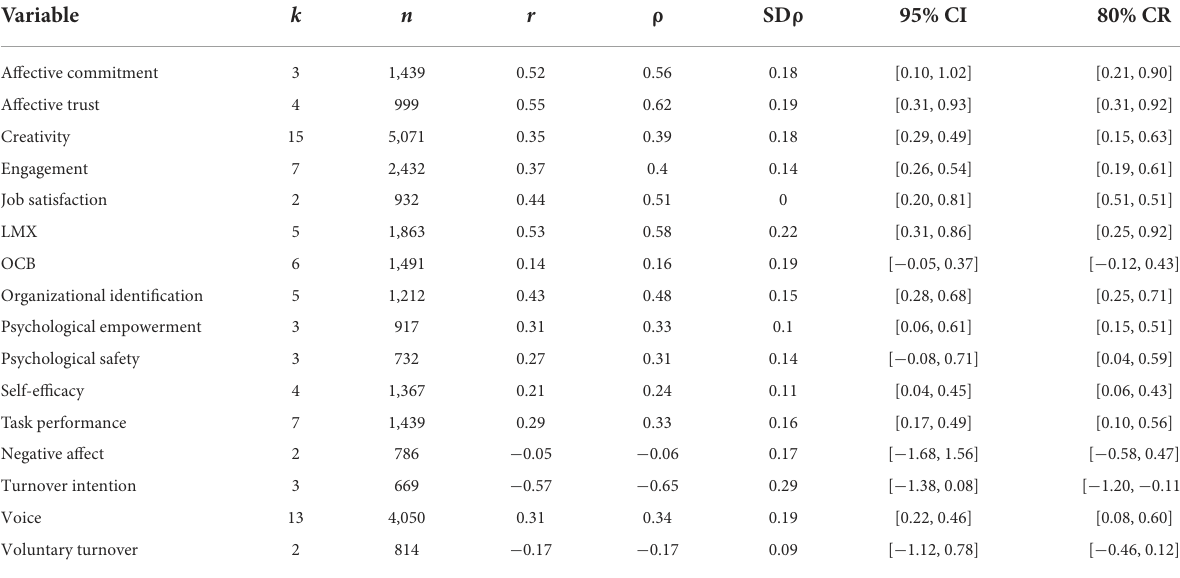
TABLE 4 Bivariate relationships between humble leadership and its outcomes.